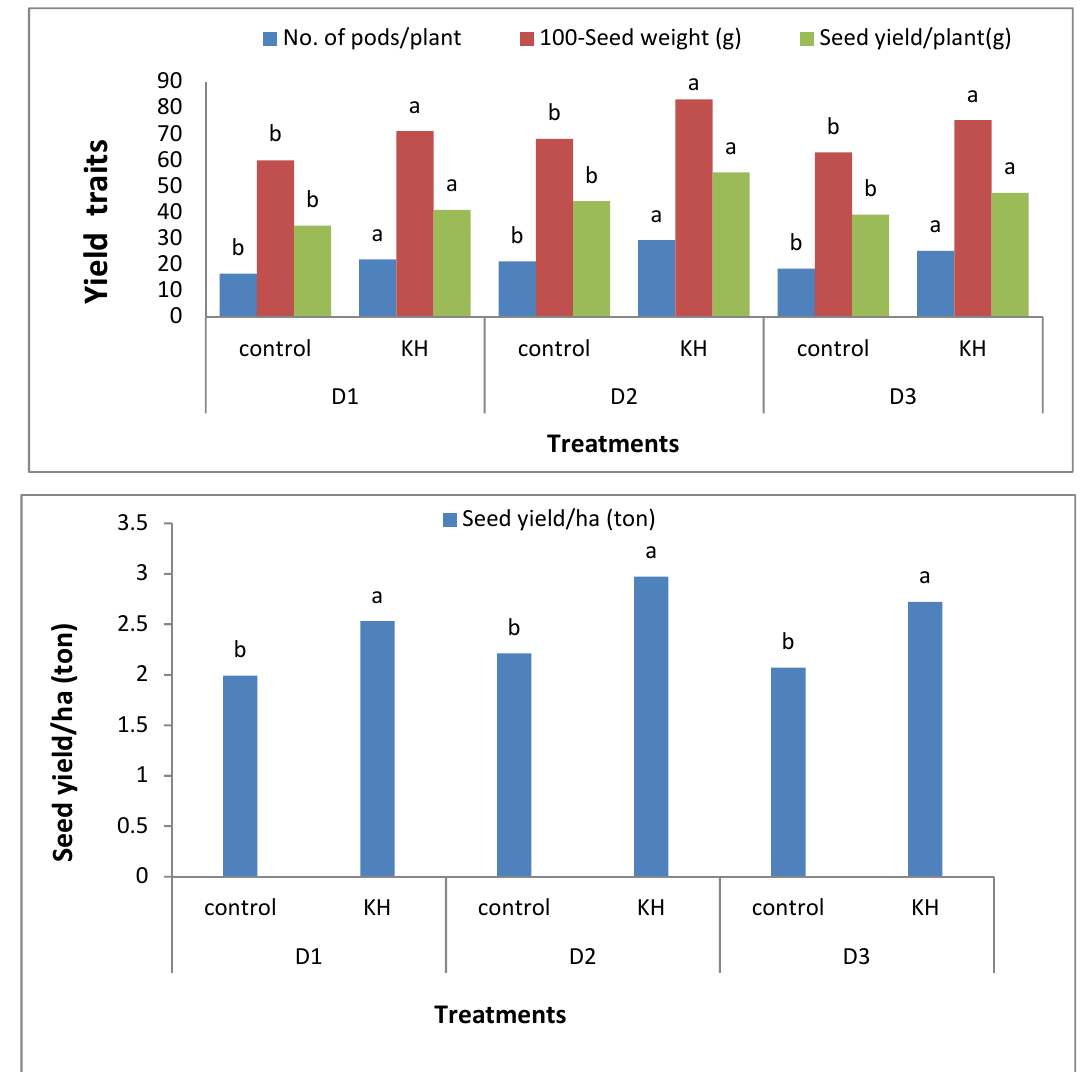
Figure 6. Effect of potassium humate (KH) application and planting density treatment on number of pods/plants, 100-seed weight (g), seed yield/plant (g) and seed yield/ha (ton) of Vicia faba L. plants. For each parameter, treatments followed by the same letter are not significantly different at p ≤ 0.05.